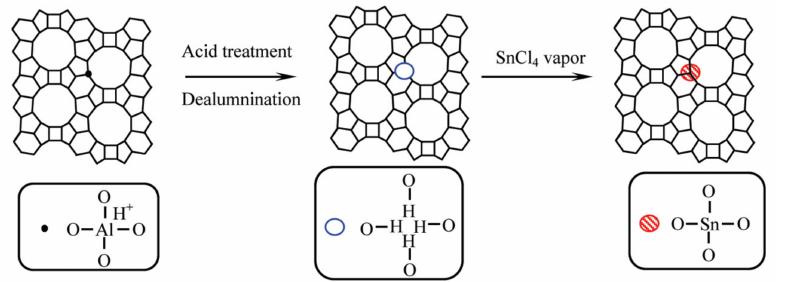
Figure 4. Strategy for post-synthesis of Sn-Beta through a combination of dealumination with solid- gas reaction (Atom-Planting Method). Reproduced with permission from [27]. Copyright 2011, American Chemical